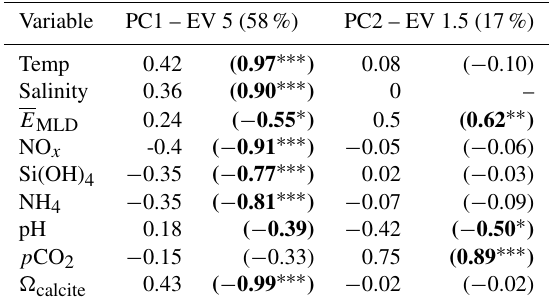
Table 3. Principal component (PC) scores, percentage of vari- ation described (%V), and the Pearson’s product moment cor- relation associated with each variable and its significance level: